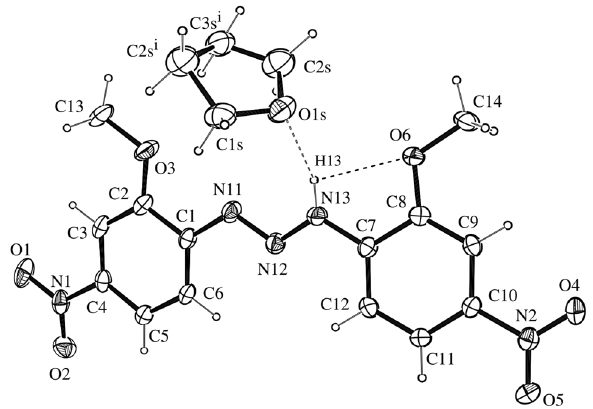
Figure 3. Molecular structure of 1, with the atom-numbering scheme. Displacement ellipsoids are drawn at the 50% probability and H atoms have arbitrary radii. The intermolecular N13-H···O1s hydrogen bonds between 1 and THF is shown as a dashed line. Symmetry code (i) − x + 1, − y, − z. The intramolecular N13 − H13 ⋅⋅⋅ O6 interaction is shown as a dashed line. Cambridge Crystallographic Data Centre (CCDC N.